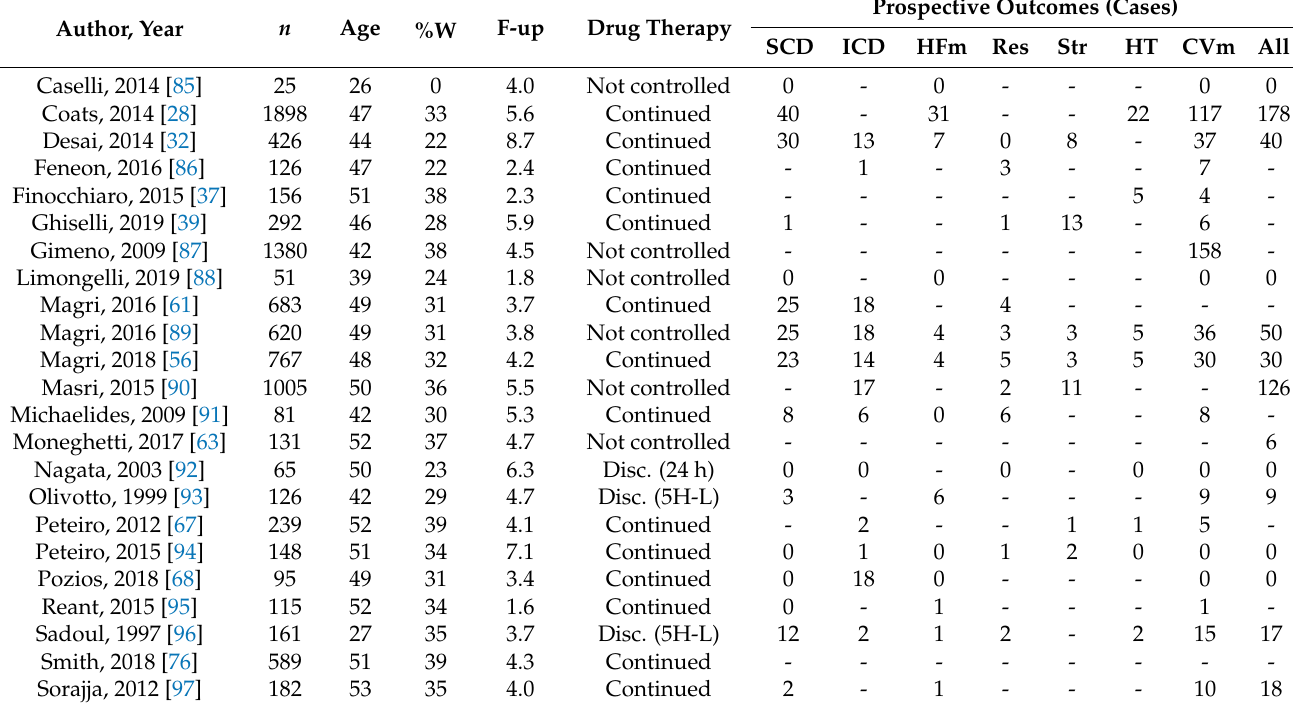
Table 2. Characteristics of prospective studies.